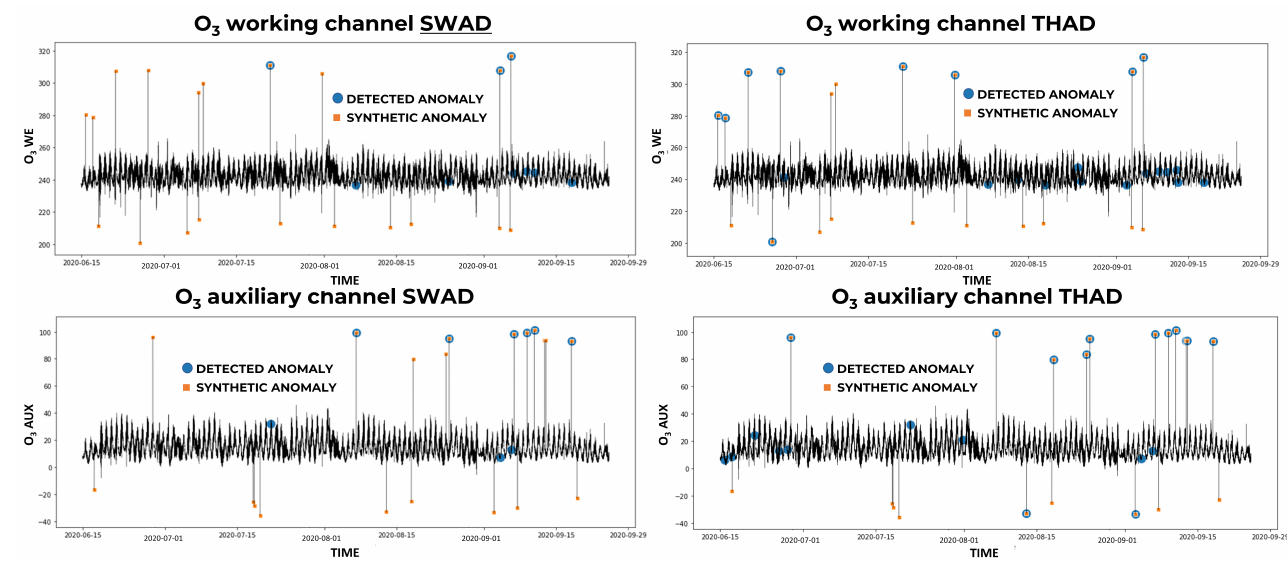
Figure 3. Extreme synthetic anomalies detected by SWAD and THAD for O 3